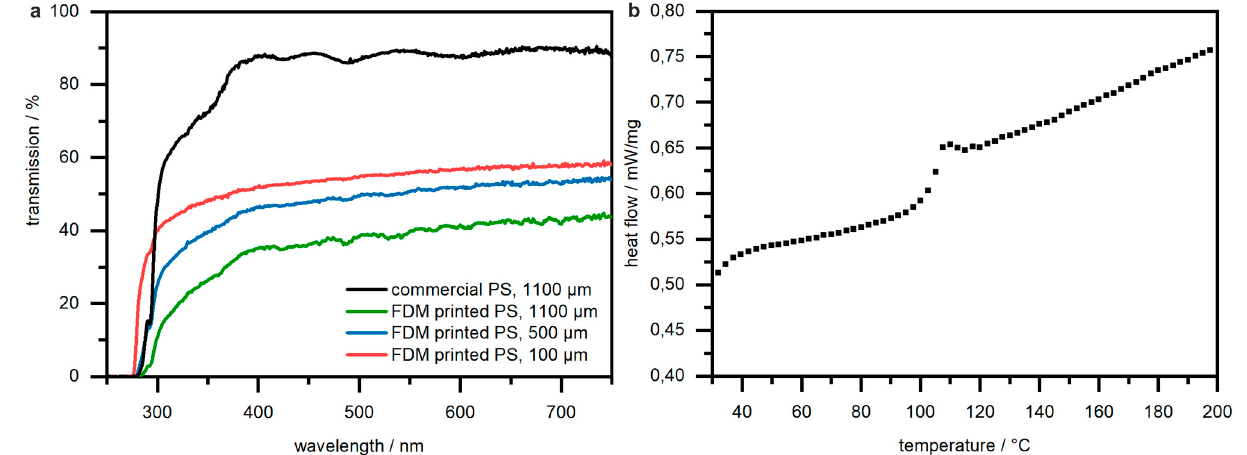
Figure 5. ( a ) UV/Vis transmission measurements on PS substrates with varying thickness (commercial PS for reference). Transmission values up to 58% were achieved with a layer thickness of 100 µm, whereas the maximum transmission was 44% for thicknesses up to 1100 µm. ( b ) DSC graph of FDM-printed PS. Samples were heated from 20 to 200 °C with a heating rate of 10 K/min. The glass transition of the sample can be seen with an onset at 100 °C.